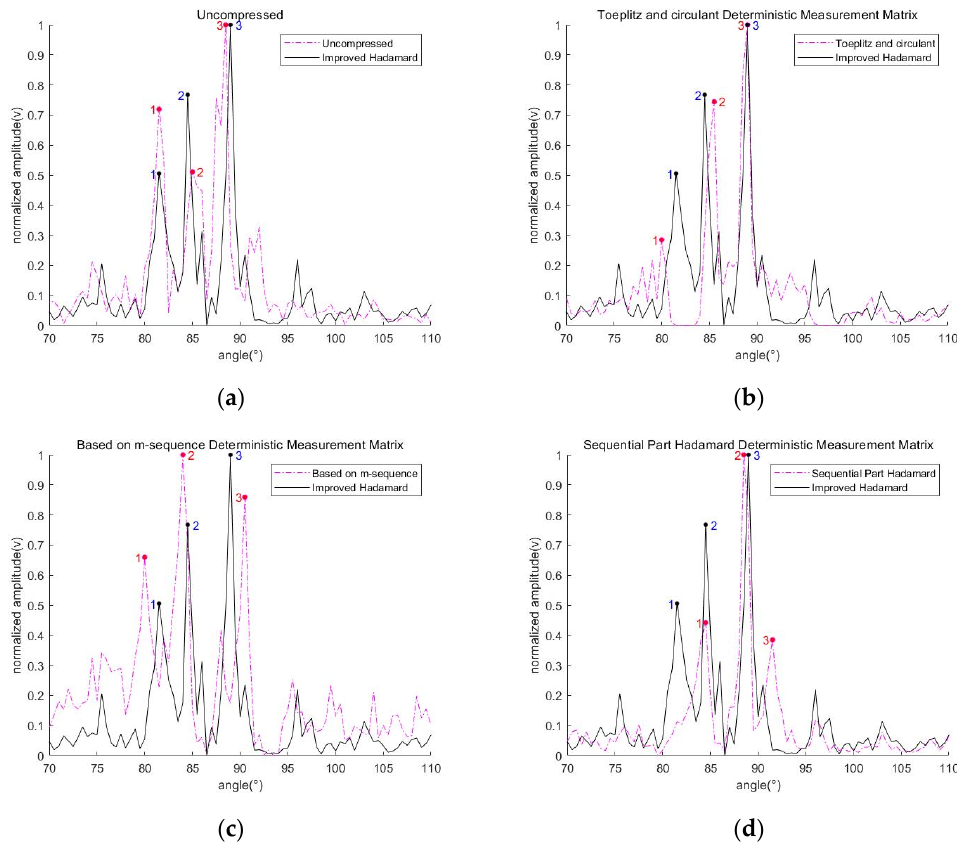
Figure 10. The reconstructed targets with different measurement matrices in 70% compression ratio: ( a ) the reconstructed targets under uncompressed observations; ( b ) the reconstructed targets with Toeplitz and circulant Deterministic Measurement Matrix; ( c ) the reconstructed targets with based on m-sequence Deterministic Measurement Matrix; and ( d ) the reconstructed targets with sequential Part Hadamard Deterministic Measurement